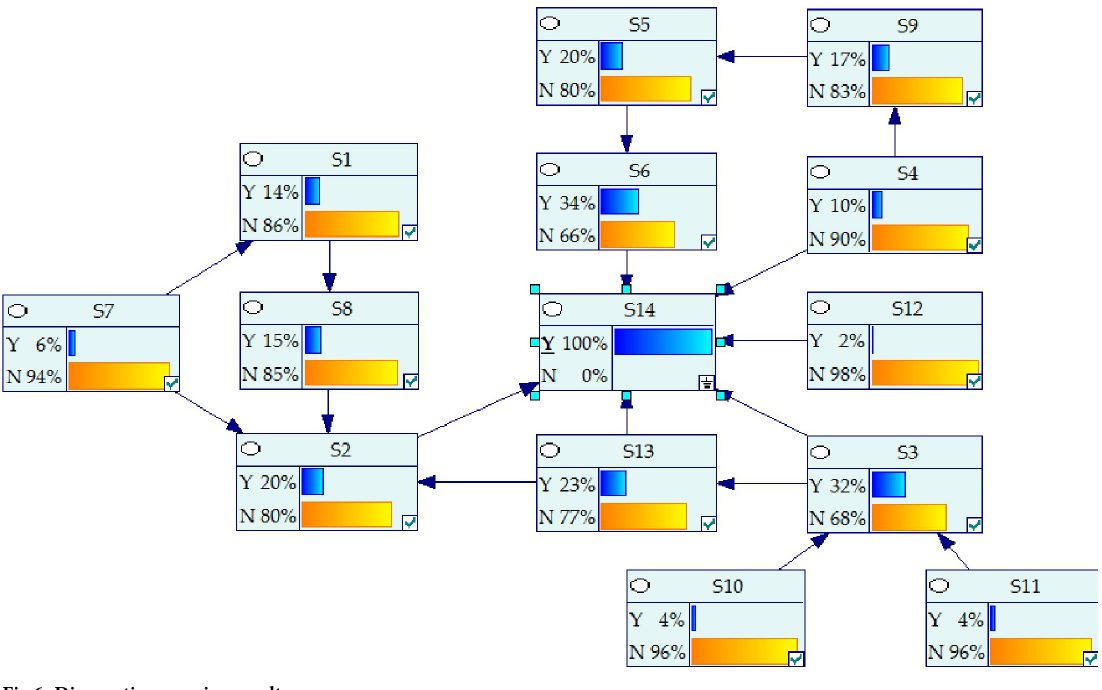
Fig 6. Diagnostic reasoning results.